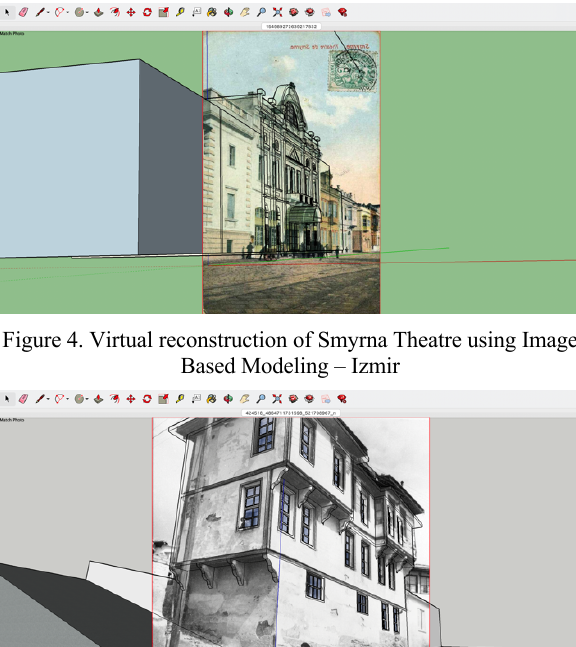
Figure 3. Virtual reconstruction of London Hotel using Image Based Modeling – Izmir